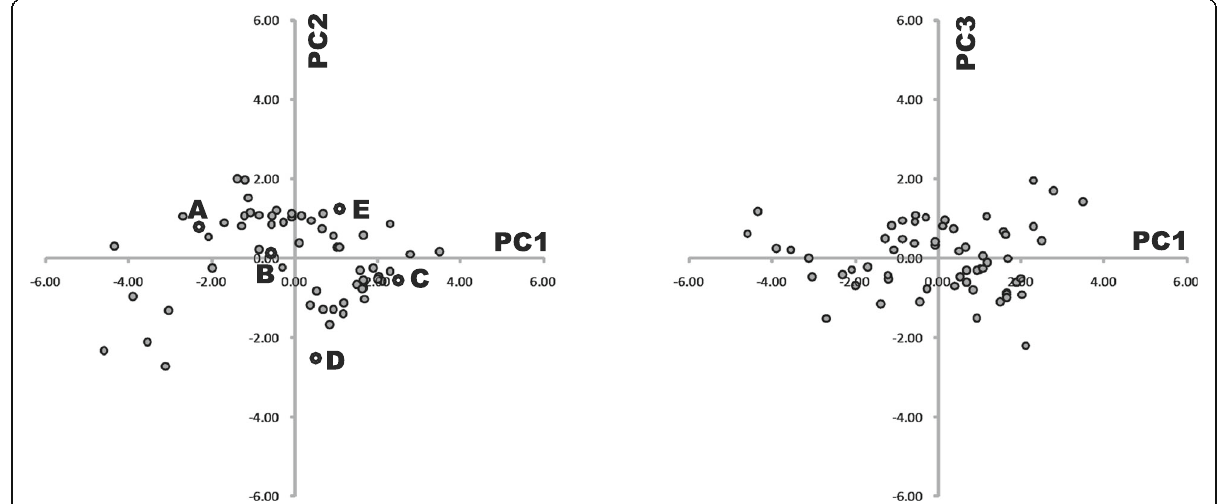
Fig. 11 Scatter diagrams of PC2 and PC3 with respect to PC1. The shape of the grain-size distribution of samples A – E is shown in Fig.